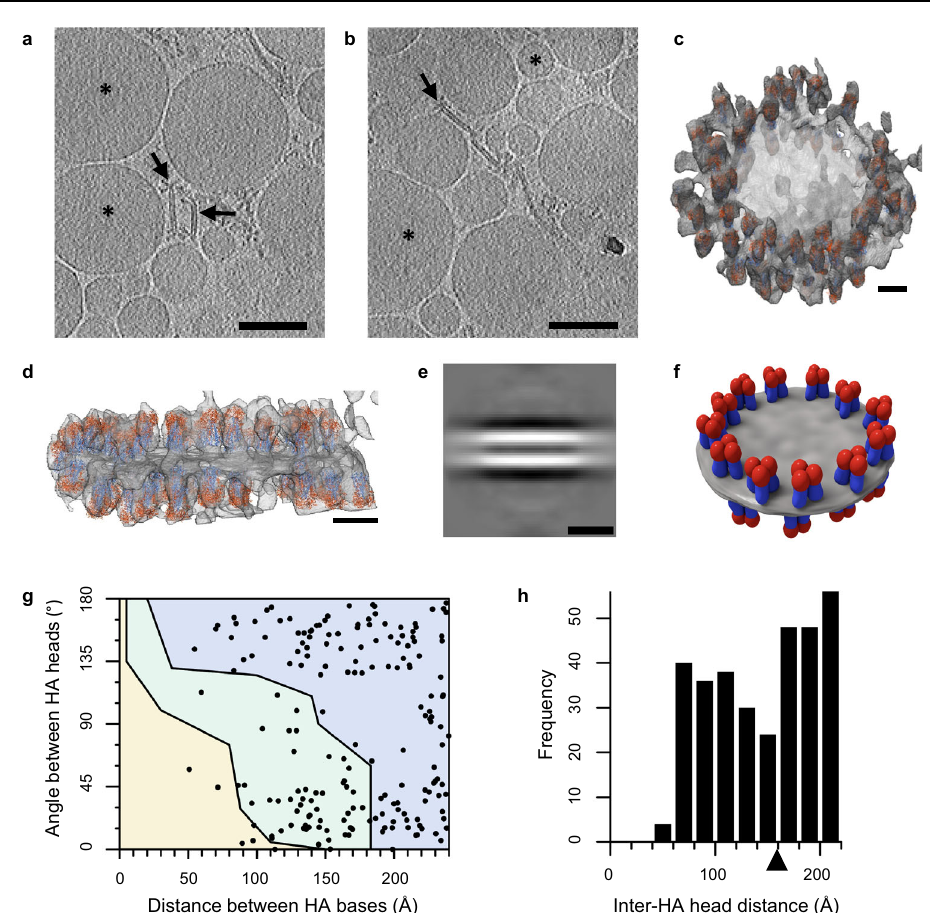
Fig. 4 | Fluad structural analysis by cryo-electron tomography and molecular modeling.a , b Examplesofslicesthrough cryo-electrontomogramswitha fi eld of Fluad spike complexes and putative adjuvant vesicles. Black arrows indicate some spike complexes protruding from an apparent lipid bilayer. Black asterisks denote adjuvantvesicles. c Obliqueviewofacryoelectron-tomographic3Dreconstruction (gray) of a Fluad large particle. A disc-like structure was observed with spiked densities around its perimeter, which were used to dock HA molecules (ectodo- maintrimers,PDBID3LZG)thatwereparallelandanti-paralleloneitherthesameor different sides of the disk, respectively. HA heads were colored red, and HA stems werecoloredblue. d Side-viewoftheFluadparticleinpanel c illustratesparalleland anti-parallel HA orientation. e Side view of a subtomogram average of Fluad disc structures,focusingonthedisccenter.Twolayersofdensityarevisibleinadensity slice bisecting the disc, which indicated the discs are composed of a bilayer. The